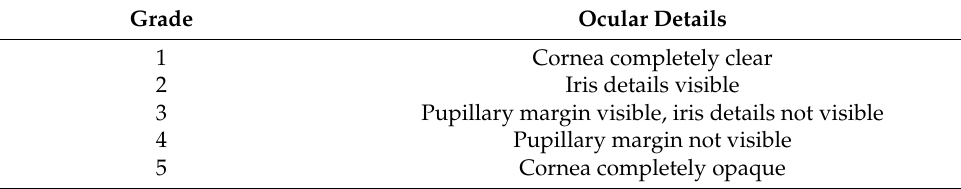
Table 2. Grading of corneal clarity on the basis of corneal haze. Grade Ocular Details 1 Cornea completely clear 2 Iris details visible 3 Pupillary margin visible, iris details not visible 4 Cornea completely